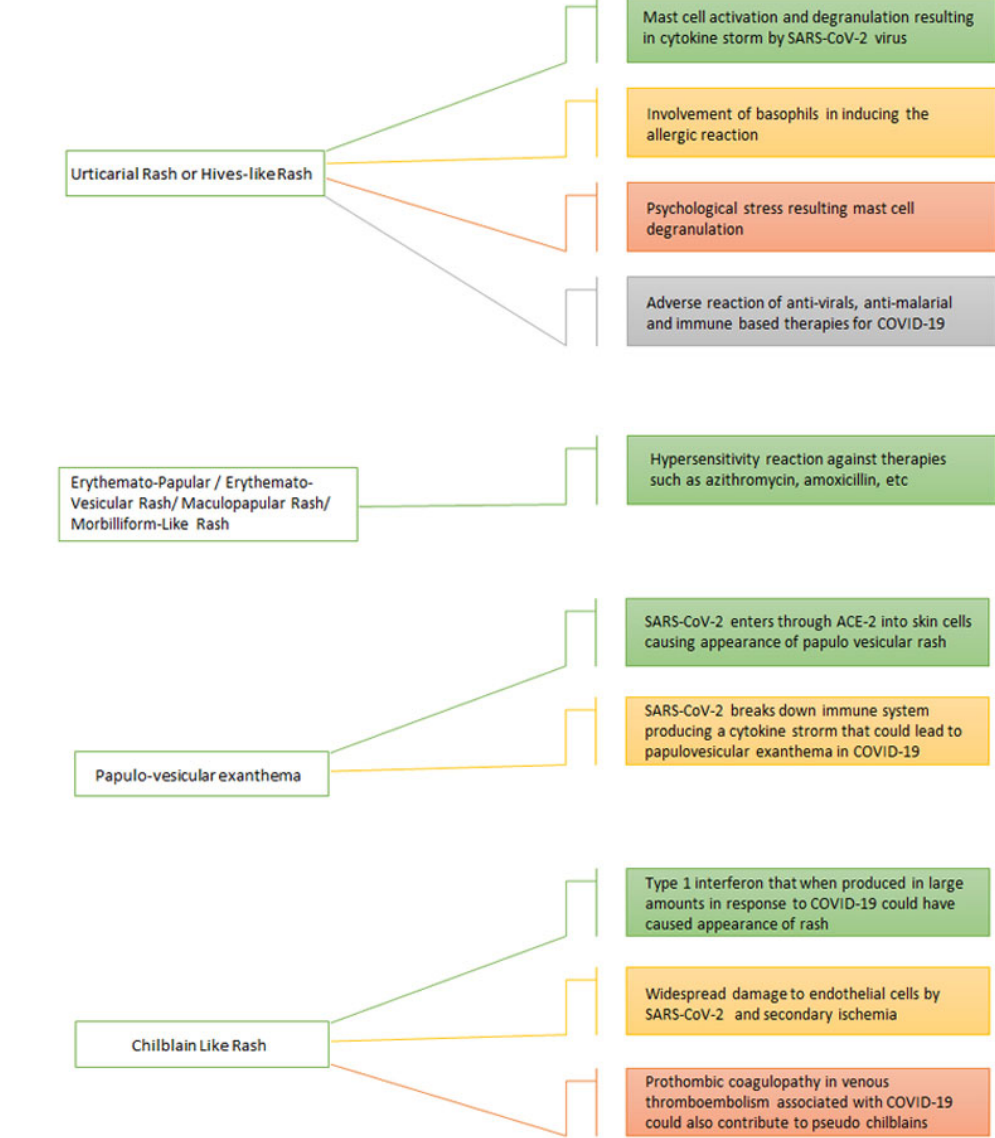
Figure 2. Pathogenesis behind cutaneous manifestations of COVID ‐ 19.